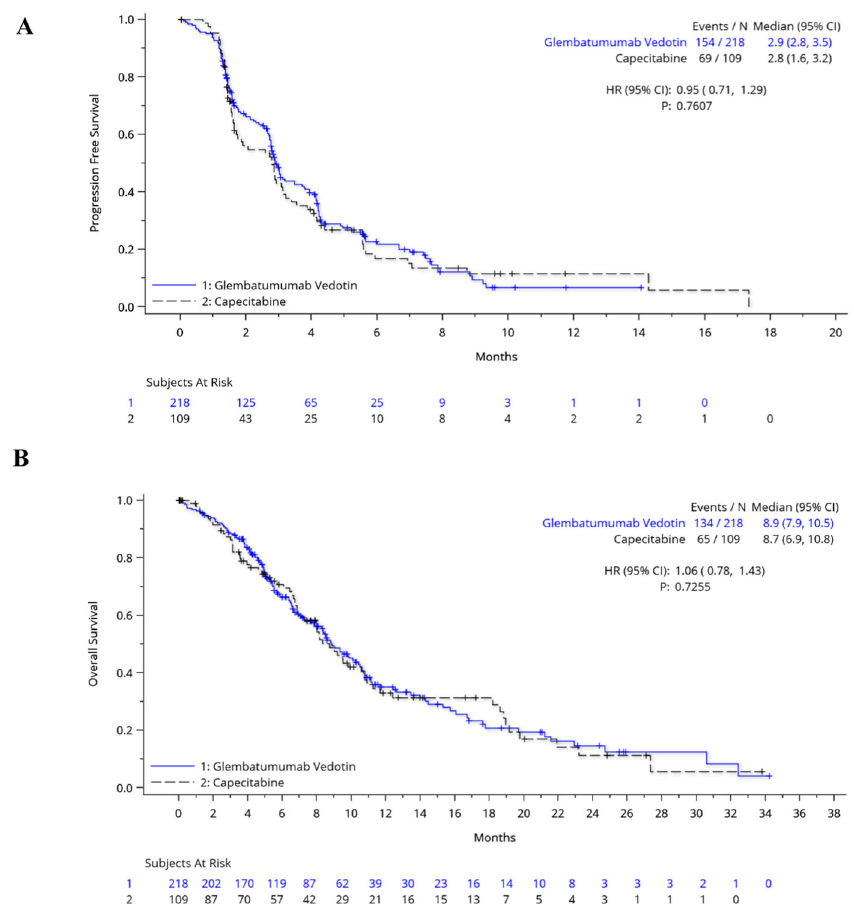
Fig. 2 Kaplan – Meier estimates of progression-free survival and overall survival. PFS by IRC assessment ( A ) and OS ( B ) for the intention-to- treat population are shown in months. Tick marks represent censored